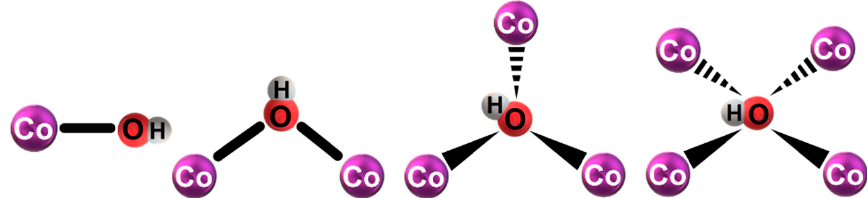
Figure 5. Models of the hydroxyl ions coordinated to the cobalt ions in the process of water oxida- tion.